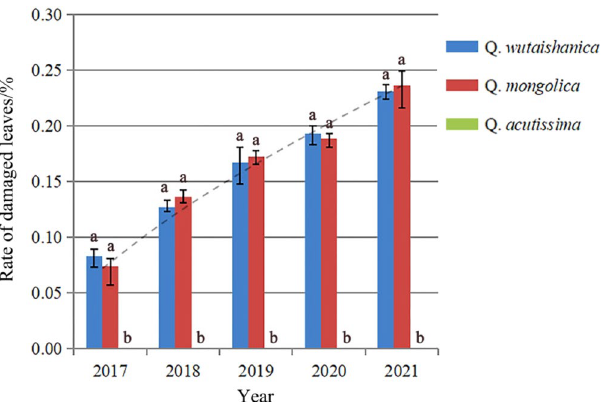
Figure 9. Host plant preference analysis and damage trend of Rhynchaenus maculosus larva from 2017 to 2021. Significant difference of host preference is indicated by the letters a and b; The dotted line indicates the damage trend of pest larvae.